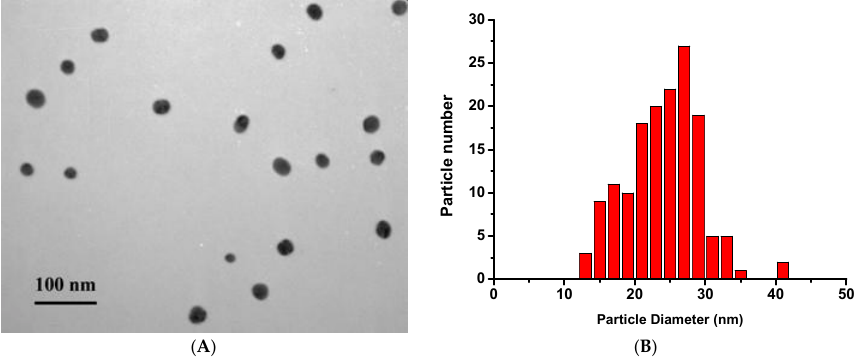
Figure 1. ( A ) TEM image of gold nanoparticles. ( B ) A histogram of the gold nanoparticles (GNPs) distribution by diameter (basing on TEM data). n = 152.